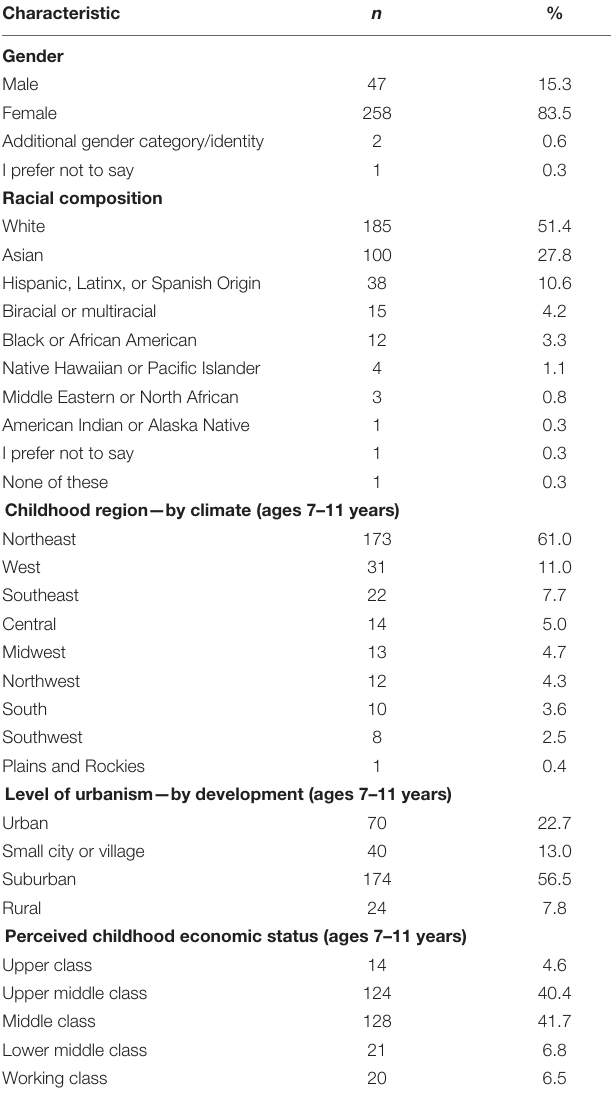
TABLE 2 | Frequency statistics by demographic